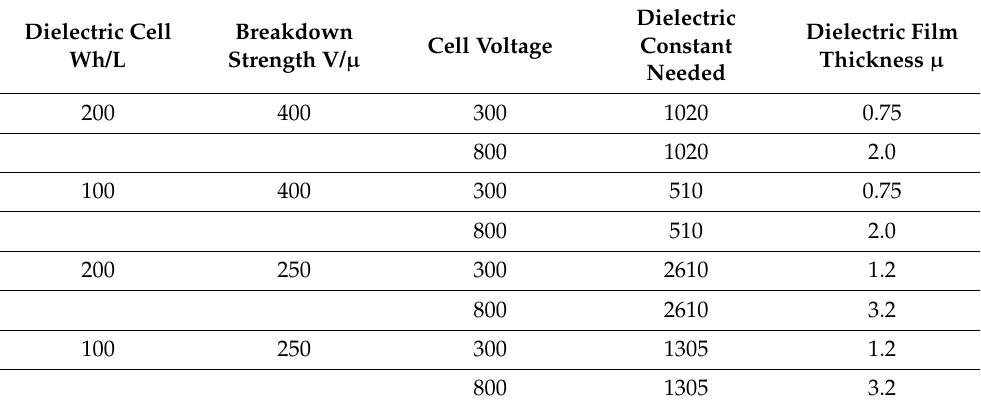
Table 1. The effect of breakdown strength on the required dielectric constant for cells of high energy